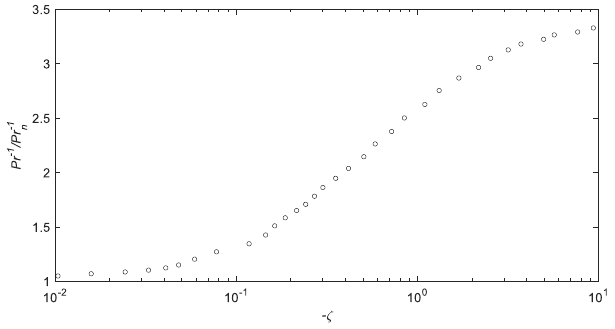
Figure A1. The variation of Pr − 1 / Pr − 1 n with stability according to the spectral budget formulation of Li et al.